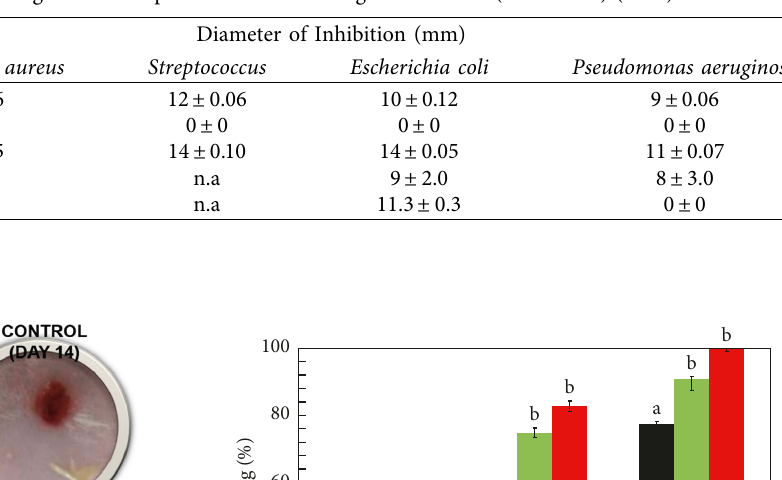
Table 2: Inhibition zone of biofilms against Gram-positive and Gram-negative bacteria (mean